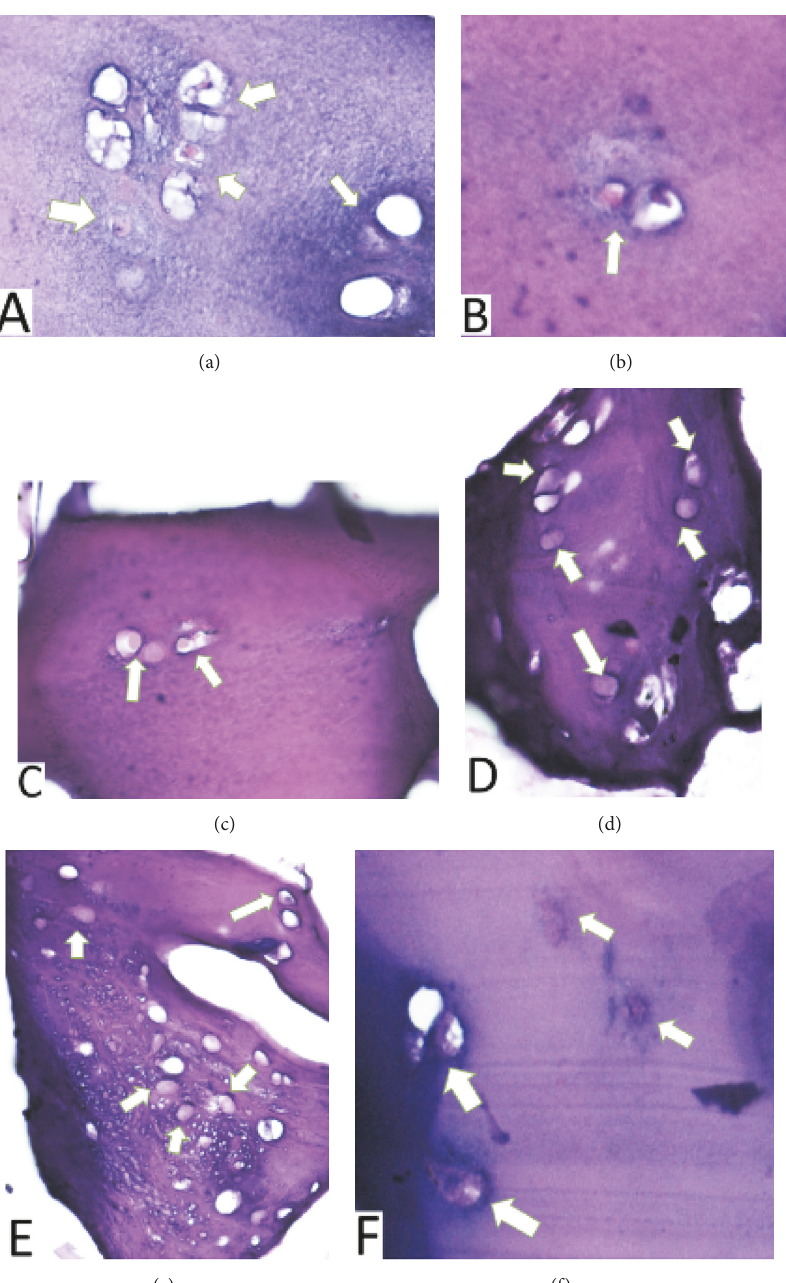
Figure 9: Hematoxylin-Eosin staining in 2 weeks after hBM-MSCs seeding. (a-c) SBCS group and (d-f) DSBCS group. White arrow showed